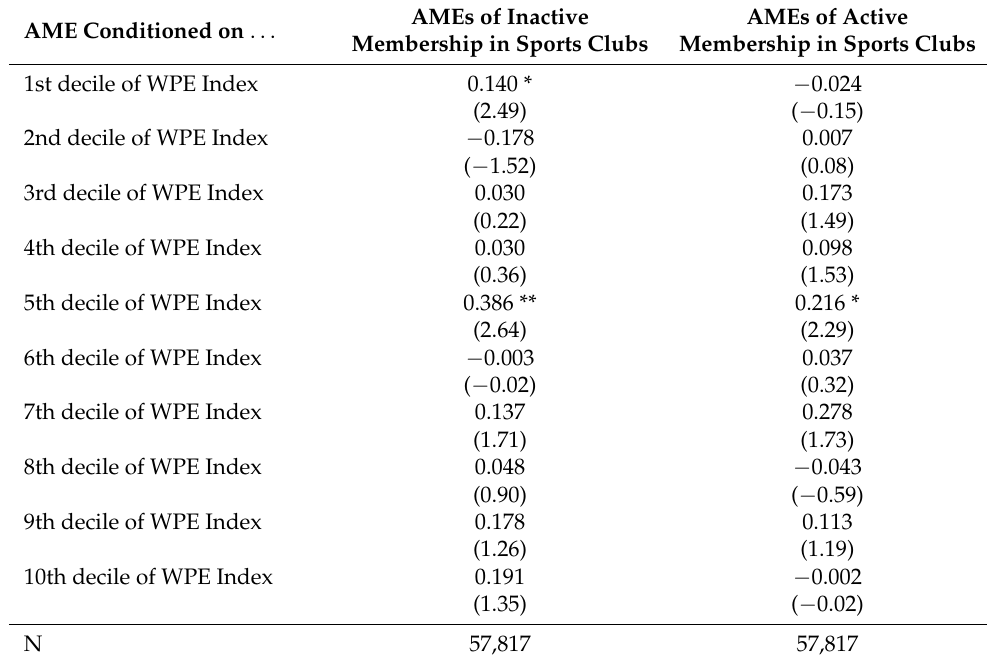
Table A4. Average marginal effects (AMEs) from inactive and active membership in sports clubs on sexist gender ideologies conditioned on the WPE Index. Results for the males. We included 95% confidence intervals using robust standard errors. Source: WVS-EVS-data and V-Dem data. AME Conditioned on . .